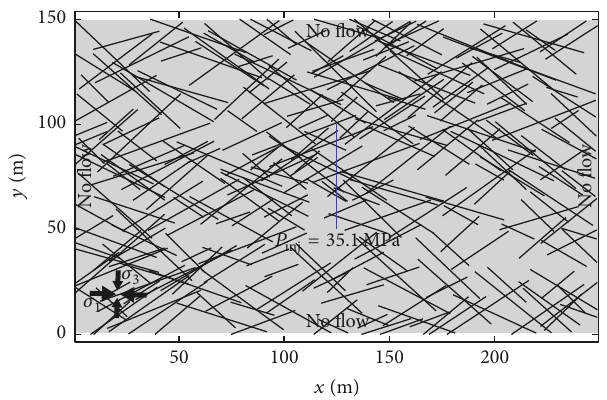
Figure 13: Numerical setup to evaluate the spatial and temporal evolution of potential slip due to fluid pressure and thermal stress. A constant injection pressure is applied to the borehole in the middle of the domain (blue). On the outer boundaries, a no-flow boundary condition is applied.